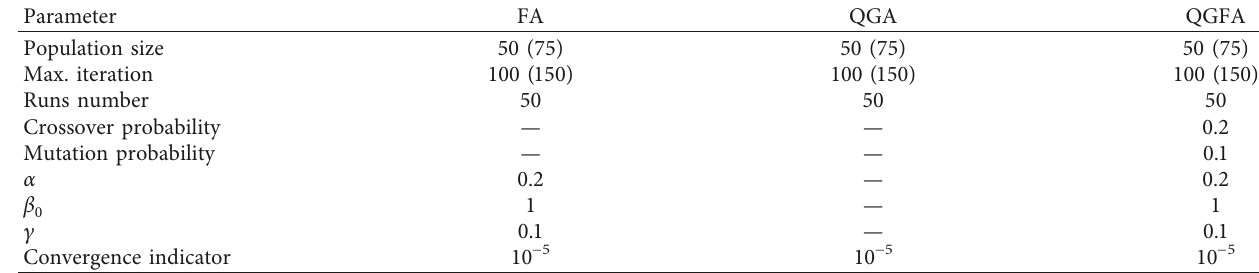
Table 2: FA, QGA, and QGFA parameter settings [12, 13].